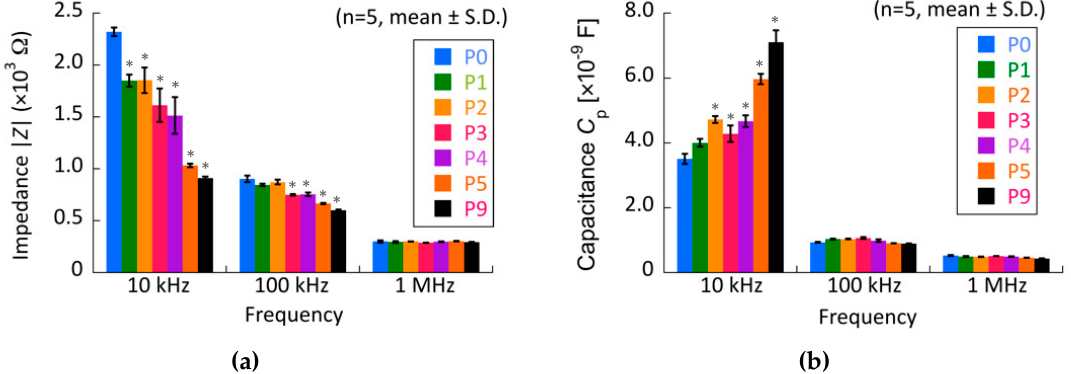
Figure 8. Effect of passage number on the ( a ) electrical impedance and ( b ) capacitance of chondrocytes. * indicates a significant difference in each value compared to that of primary cells (P0), p < 0.05.